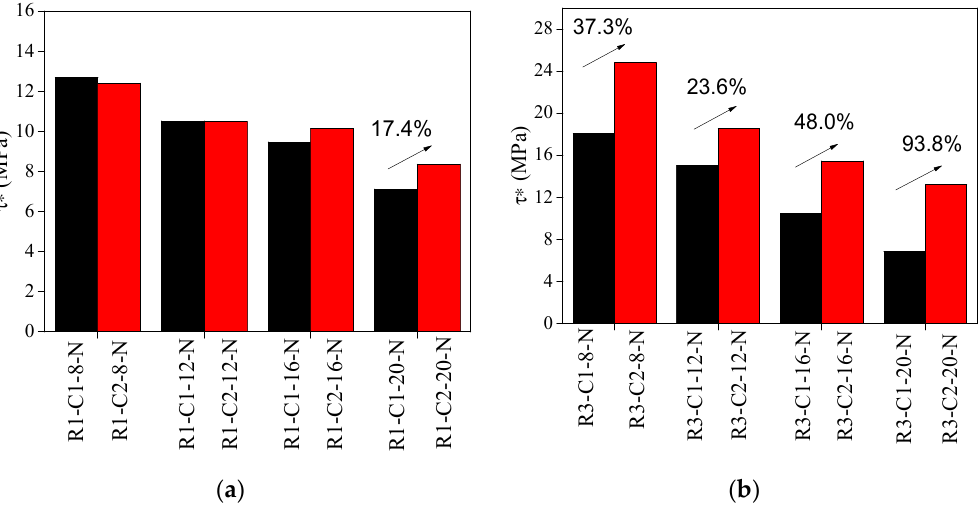
Figure 11. Comparison of average bond strength of R1 and R3 bars in C1 and C2 concrete without stirrups. ( a ) R1 bars ( b ) R3 bars.